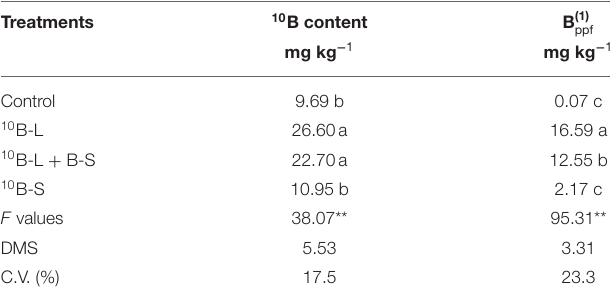
TABLE 1 | Leaf concentration of B in new leaves emerged after leaf application, percentage of 10 B from fertilizer in cowpea plants submitted to the application of marked and unmarked B, on the substrate and on the